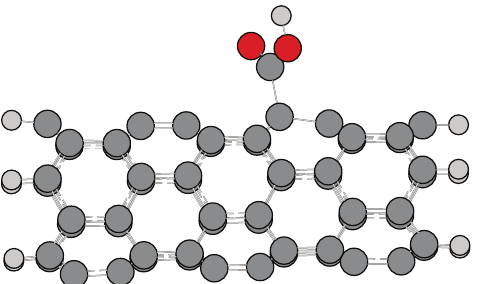
Figure 2: Optimized geometry of the finite (5, 0) zigzag SWCNT (C 60 H 20 ) with the formic acid radical at the tube sidewall. Gray color depicts carbon atoms; light gray is hydrogen and red is oxygen.